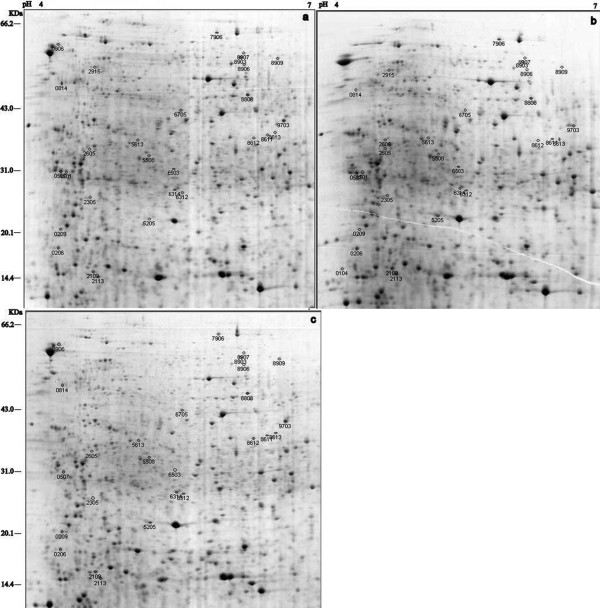
Two-dimensional electrophoresis gel of separated proteins at three developmental stages. The pre-albinistic stage (a), albinistic stage (b) and regreening stage (c). Proteins were separated in an IPG strip (pH 4-7) and in the second dimension on a 12.5% gel. Proteins that exhibited a significant expression change (≥ 1.5-fold, p-value ≤ 0.05) from stage a to b while from stage b to c are labeled in the figures.